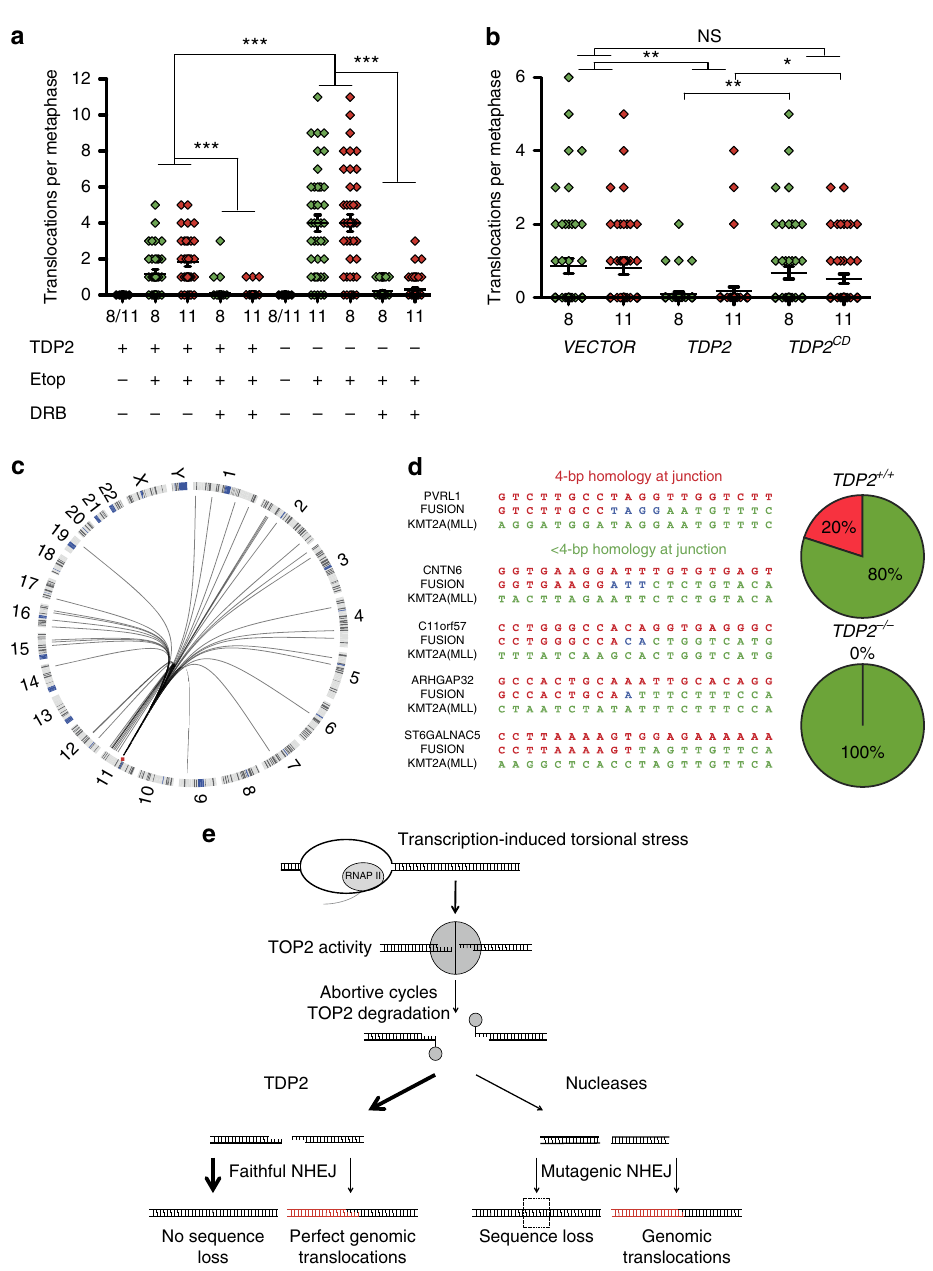
Fig. 4 TDP2 suppresses TOP2-induced chromosome translocations. a Translocation frequencies (translocations/metaphase) in chromosomes 8 and 11 were quanti fi ed in serum-starved (G1/G0) cells in metaphase spreads prepared 48 hr after mock-treatment or etoposide treatment (1 h, 100 µ M). In the absence of etoposide, translocations for both chromosomes are plotted together (8/11). Where indicated, cells were pre-treated with DRB (100 µ M) for 3 h prior to, during, and 4 h after etoposide treatment to inhibit transcription. Data are from two independent experiments and statistical signi fi cance was measured by T -tests (*** P < 0.001). b Translocation frequencies in etoposide-treated TDP2 − / − RPE-1 infected with empty lentiviral vector or with lentiviral vector encoding wild-type TDP2 or catalytic mutant TDP2 D262A ( TDP2 CD ). Data are from two independent experiments and statistical signi fi cance was determined by T -tests (* P < 0.05,** P < 0.005, NS, not signi fi cant). c Circos plot showing the genomic distribution of MLL translocation partners in etoposide-treated wild-type RPE-1 cells. The location of MLL in chromosome 11 is indicated ( red ). Resolution; cytogenetic bands. d Left , representative junction sequences of etoposide-induced MLL translocations with 4-bp (top) or < 4-bp regions of junction homology ( bottom three). Right , distribution of translocation junctions with 4-bp or < 4-bp regions of homology in WT and TDP2 − / − RPE-1 cells. e Model depicting the in fl uence of TDP2-dependent and independent NHEJ on translocations at TOP2-induced DSBs during transcription. Left , TDP2 primarily promotes rejoining of the correct (adjacent) termini ( left , thick arrow) but occasionally may promote joining of incorrect (distal) termini with the same TOP2 cleavage sequence ( left , thin arrow). We propose that the latter events are rare but result in a translocation with 4-bp of junction homology. Right , in the absence of TDP2, processing of 5 ′ -phosphotyrosine termini requires nuclease activity and consequently error-prone NHEJ resulting in microdeletions (if the correct adjacent termini are rejoined) or translocations (if incorrect distal termini are joined) with ≠ 4-bp of junction